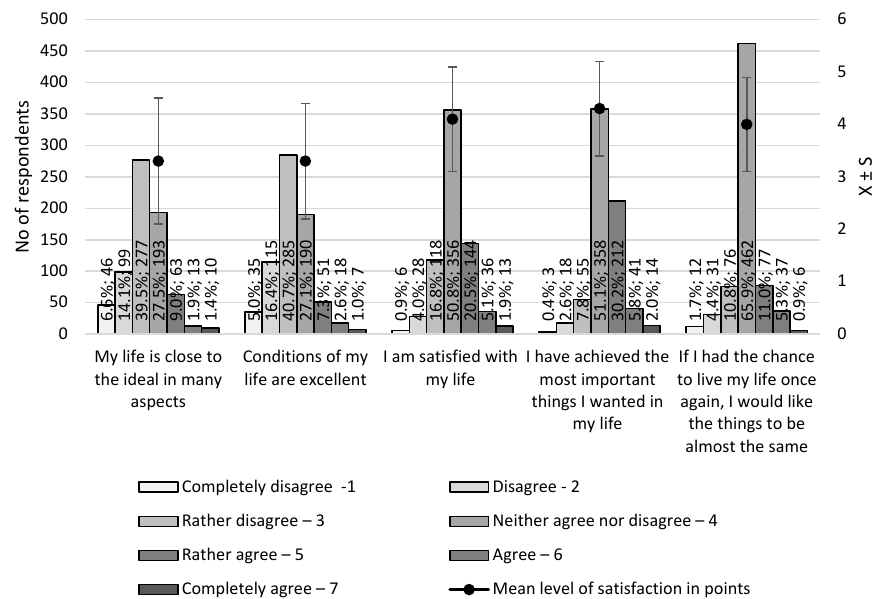
Figure 1. Results of the Satisfaction with Life Scale (SWLS).